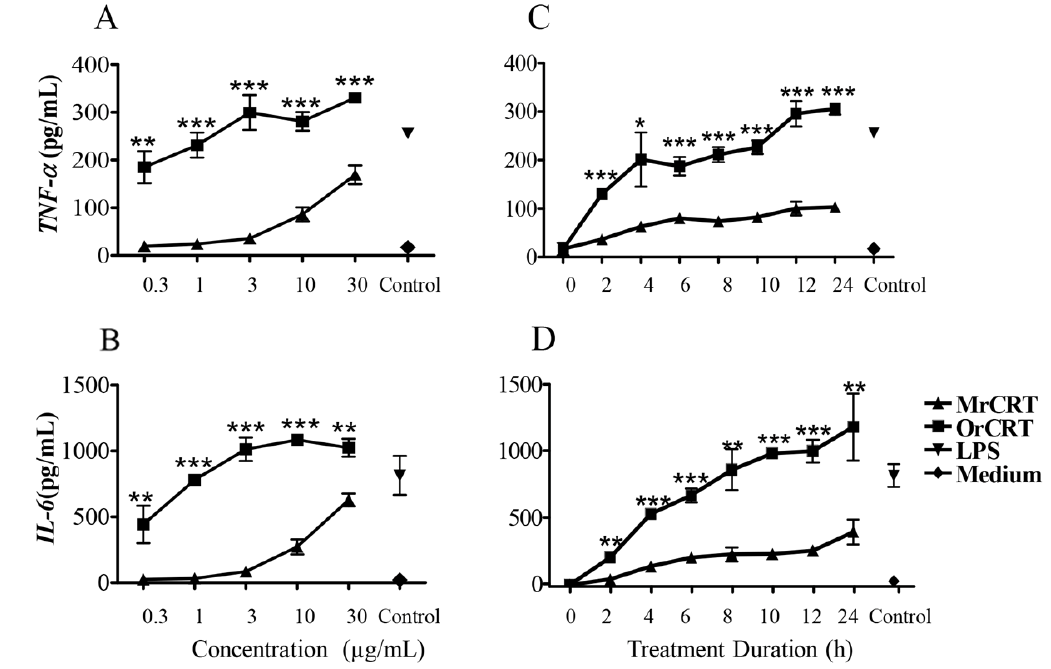
Figure 1. Tumor necrosis factor- α ( TNF- α ) and interleukin (IL)-6 expression in macrophages stimulated by recombinant calreticulins (rCRTs). Mouse peritoneal macrophages were stimulated with various concentrations of MrCRT or OrCRT for 24 h ( A and B ) or were treated with 10 μ g/mL MrCRT or OrCRT for 2, 4, 6, 8, 10, 12 and 24 h ( C and D ). TNF- α ( A and C ) and IL-6 ( B and D ) in the culture supernatant were quantitated by ELISAs. Results are expressed as mean ± SD of three independent experiments. * p < 0.05, ** p < 0.01, *** p < 0.005 oligomerized CRT (OrCRT) group vs . monomeric CRT (MrCRT)